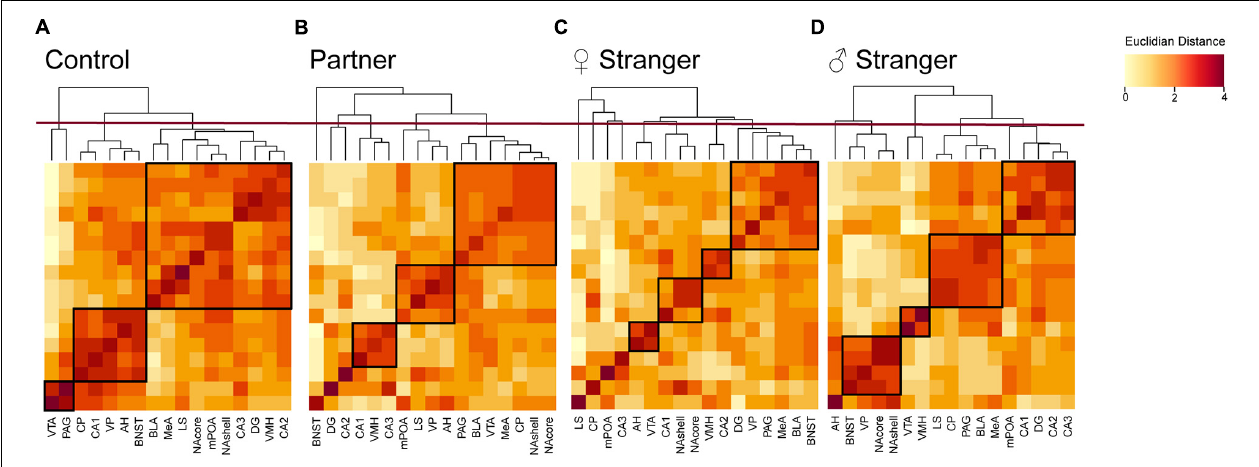
FIGURE 5 | Hierarchical clustering for each social exposure. Modules were determined by cutting each dendrogram at half of the maximal tree height (displayed by red line). Modules for each exposure are boxed in black. (A) Control dendrogram displayed three distinct modules of coactivation. (B) Partner exposure dendrogram displayed five distinct modules of coactivation. (C) Opposite-sex stranger dendrogram displayed eight distinct modules of coactivation. (D) Same sex stranger dendrogram displayed five distinct modules of